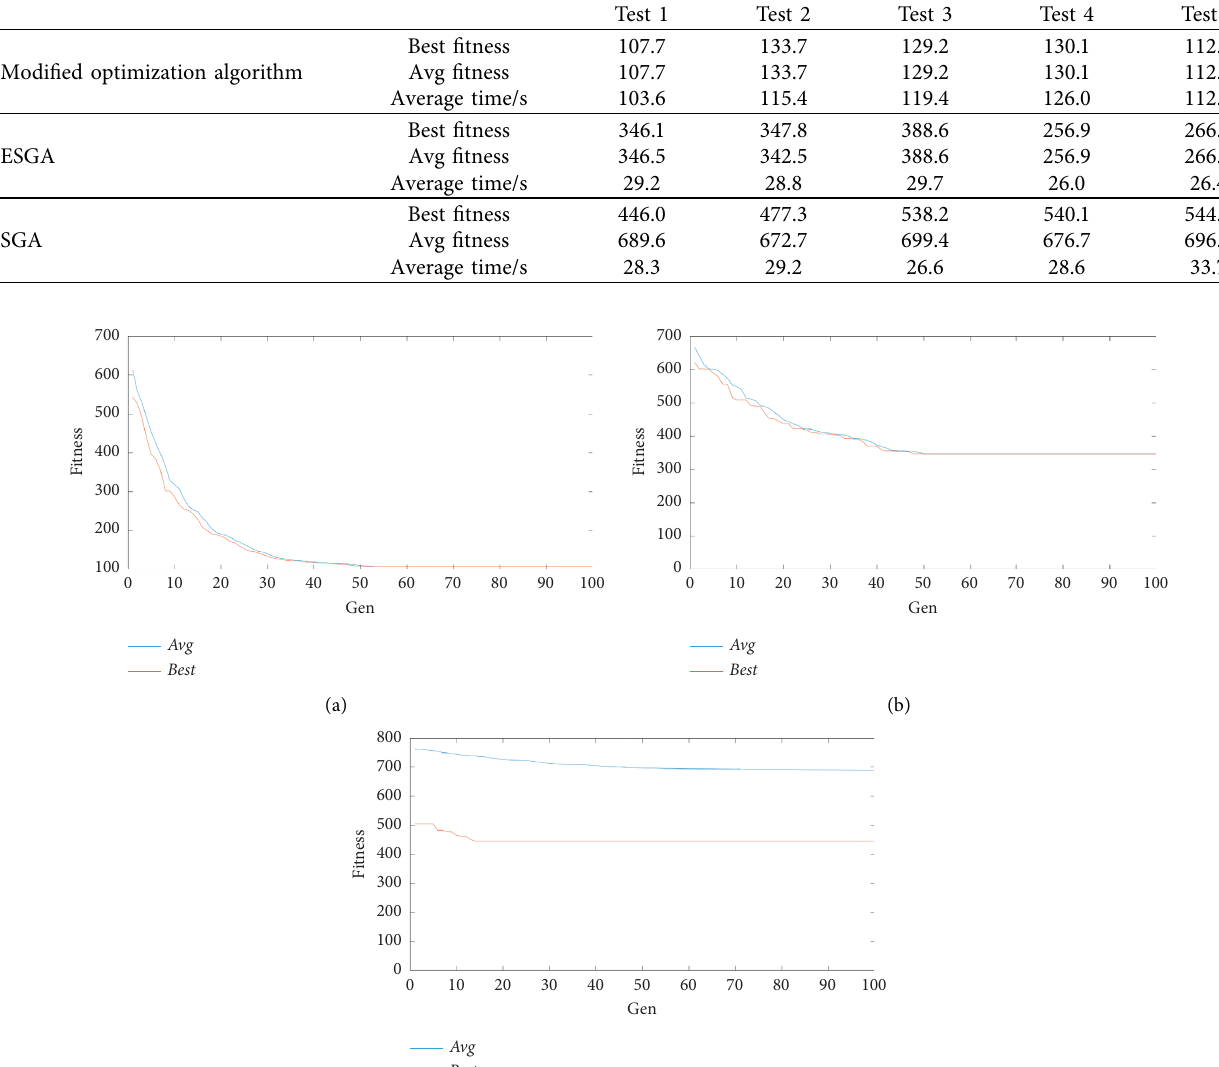
Table 1: Three methods of randomized